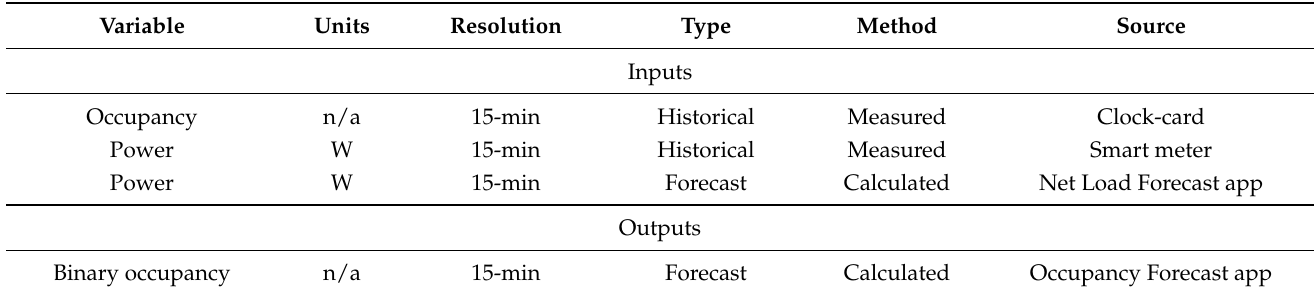
Table 7. Detailed list of inputs and outputs for supervised Occupancy Forecasting